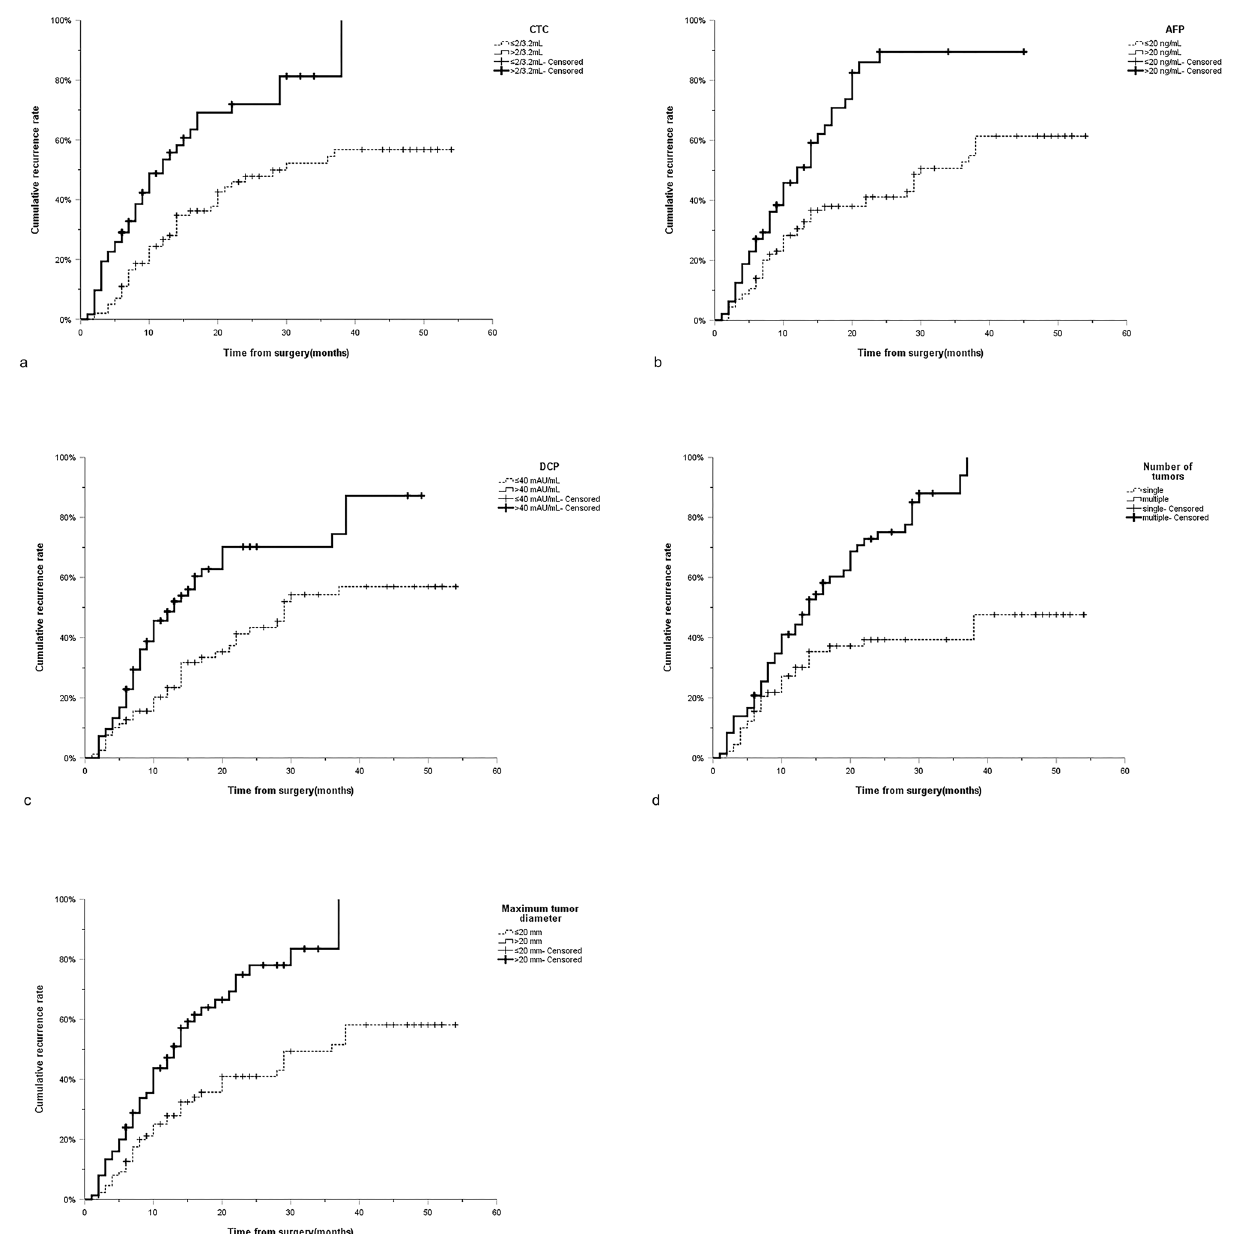
Figure 2. Curves of cumulative recurrence rate of RFA of HCC of ( a ) CTC, ( b ) AFP, ( c ) DCP, ( d ) number of tumors and ( e ) maximum tumor diameter in overall cohort. RFA Radiofrequency ablation; HCC Hepatocellular carcinoma; CTC Circulating tumor cells; AFP Alpha-fetoprotein; DCP Des-γ-carboxy